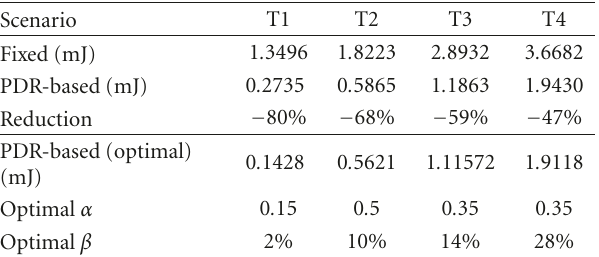
Table 2: Quantitative comparison of expected energy emission for the updating phase: IEEE